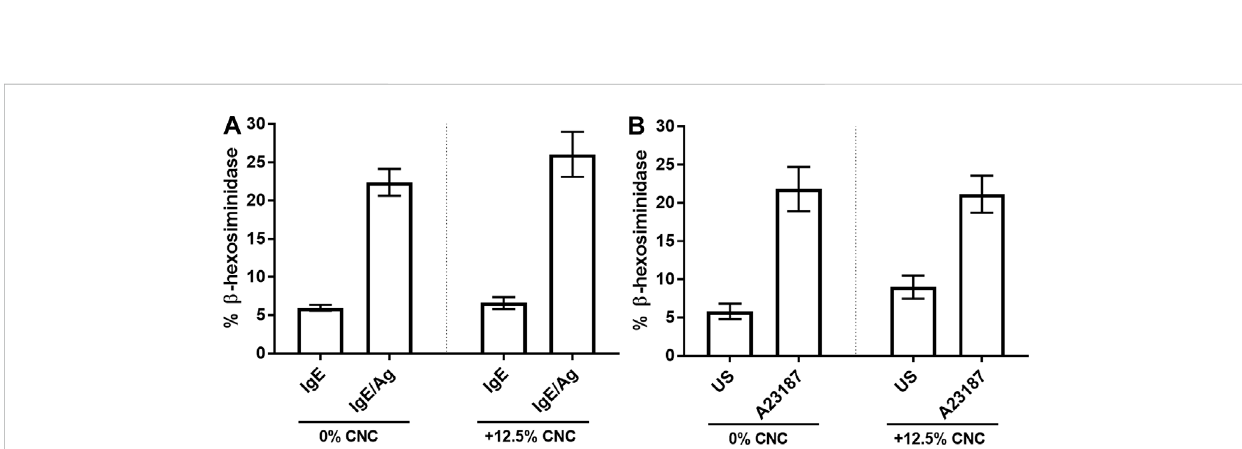
FIGURE 7 13-hexosaminidase release of BMMCs post incubation on CNC/agarose substrates. BMMC were cultured either in the absence (0% CNC) or presence (+12.5% CNC) of CNC/agarose substrates for 18 1.1, the cells were removed and activated with IgE and antigen (Ag) and 13-hexosaminidase release was measured. Cells sensitized with IgE alone (IgE) were used as a control. (B) BMMC were cultured as in (A) and activated with A23187 and 13- hexosaminidase release was measured. Uustimulated cells (US) were used as a control. Statistical analysis was performed using One-Way ANOVA with Tukey post-hoc test relative to activated cells incubated in the absence of CNC (0% CNC). Experiments were performed in quadruplicate with biological replicate of n =